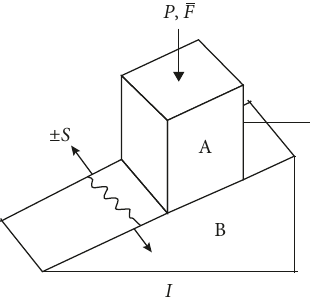
Figure 1: Junker loosening